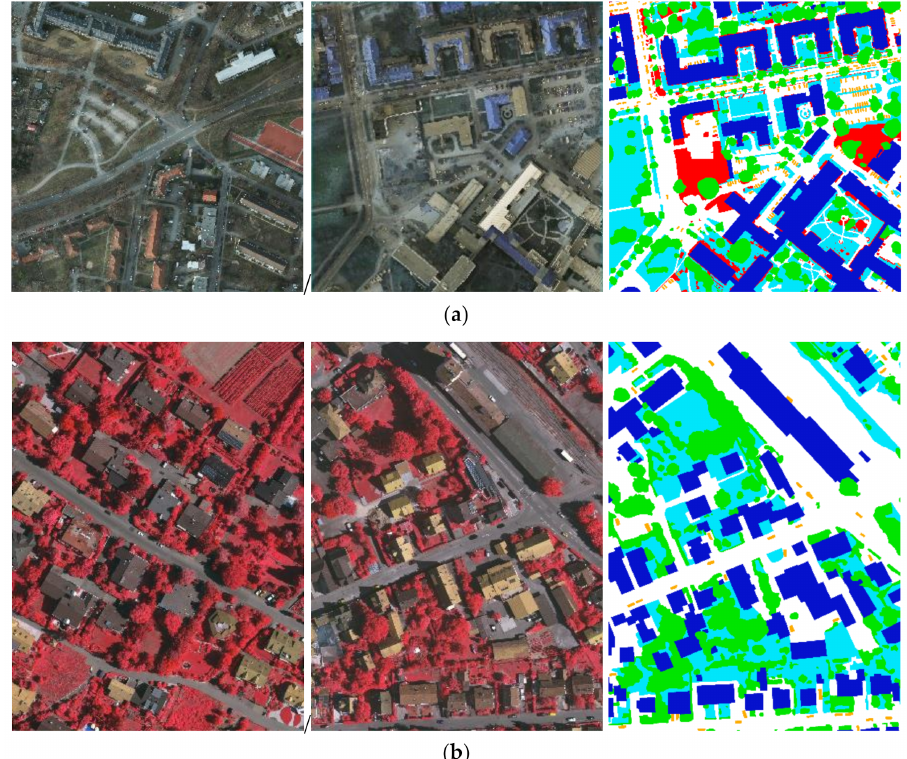
Figure 6. Datasets: ( a ) Potsdam benchmark (R, G, B) and ( b ) Vaihingen benchmark (NIR, R, G). In these two datasets, six classes of ground targets are labeled; namely, impervious surface (white), build (dark blue), low vegetation (cyan), tree (green), car (orange), and background (red). The background class contains targets that are easy to distinguish, like a pond or are distinctive like a